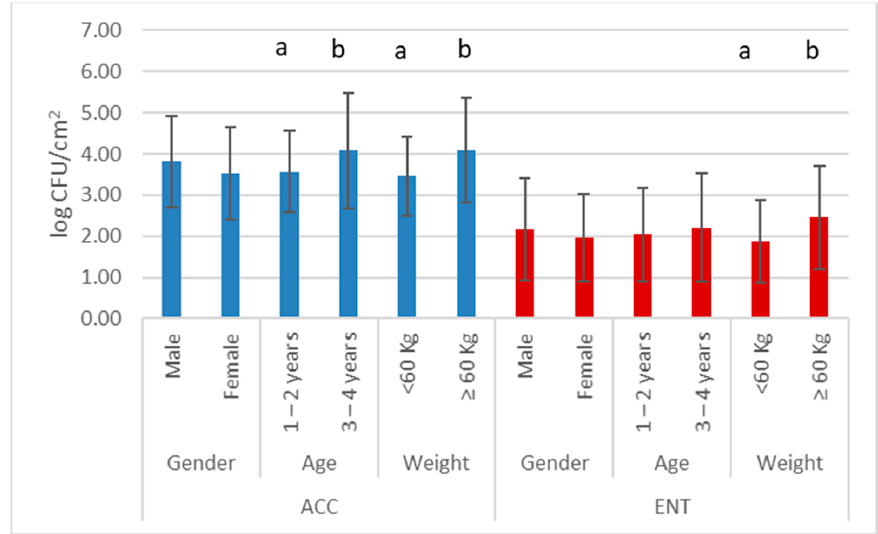
Figure 3. Mean values and standard deviation (bars) of aerobic colony count (ACC) and Enterobacteriaceae count (ENT) relative to hunted wild boar characteristics; n = 120. Different superscript letters for factors indicate statistically different mean values ( p < 0.05).